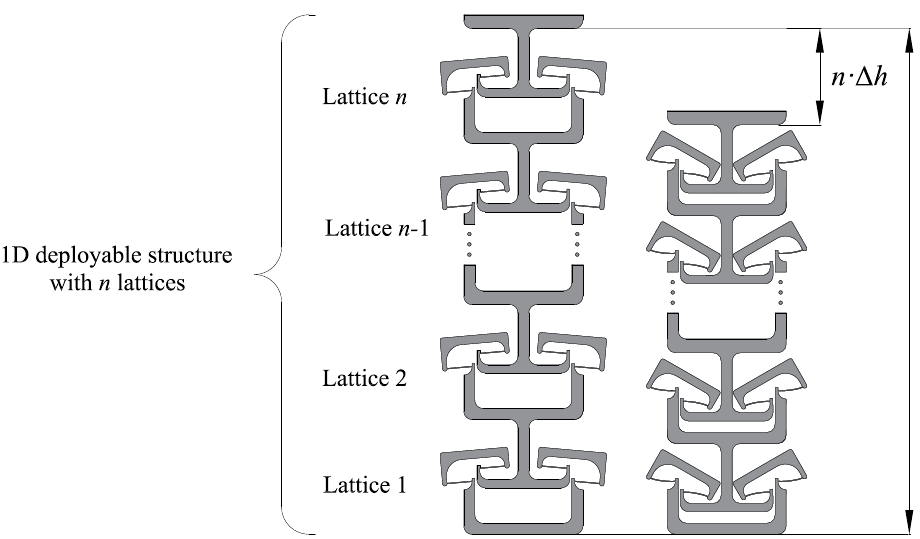
Figure 8. The multi-stable mechanism derived by tessellating bistable